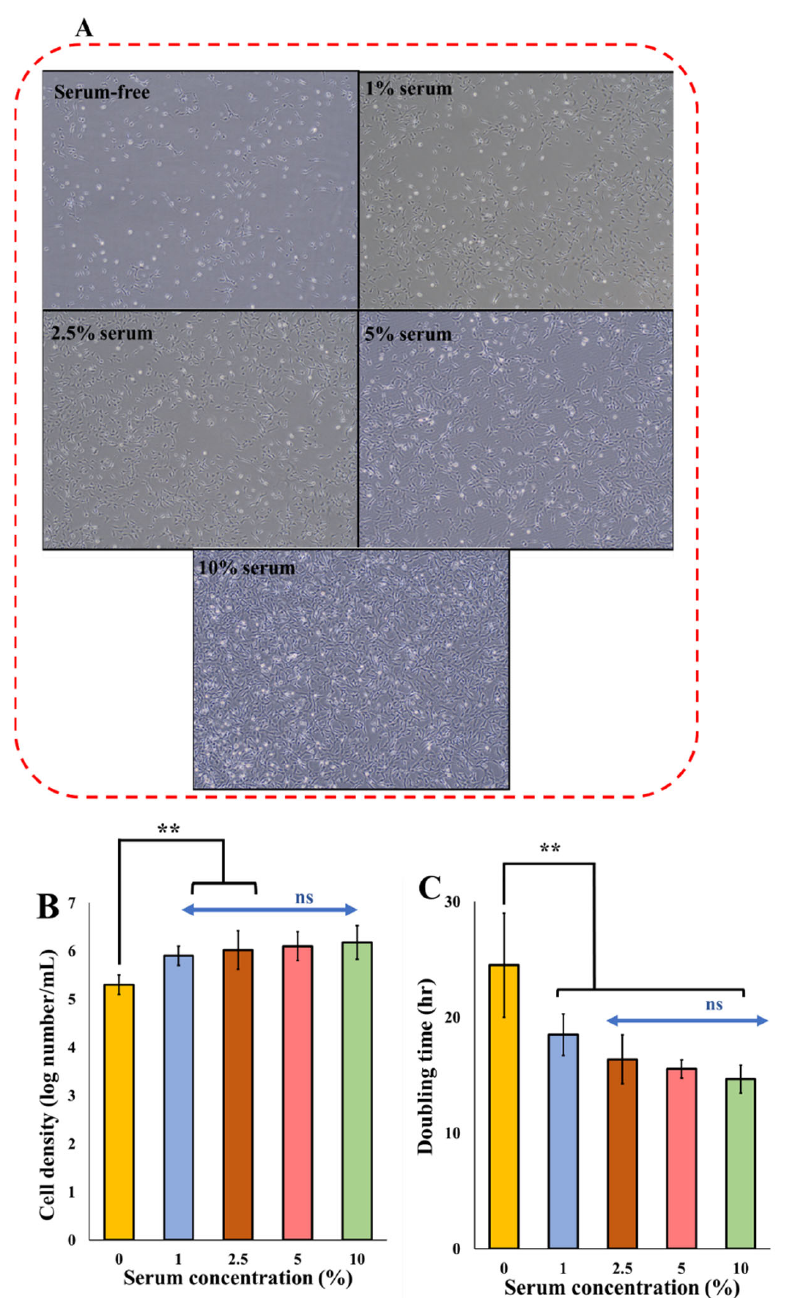
Figure 2. Cell growth parameters of ZEM2S cells at various serum concentrations: ( A ) The effect of different concentrations of serum on cell morphology and density through phase-contrast microscope; ( B ) Cell density at different concentrations of serum. ns: non-significant, (**) significant ( p < 0.05); ( C ) doubling time calculated based on the specific growth rate of the cells. Micrographs of ZEM2S cells were obtained at 10 × (200 µ m)